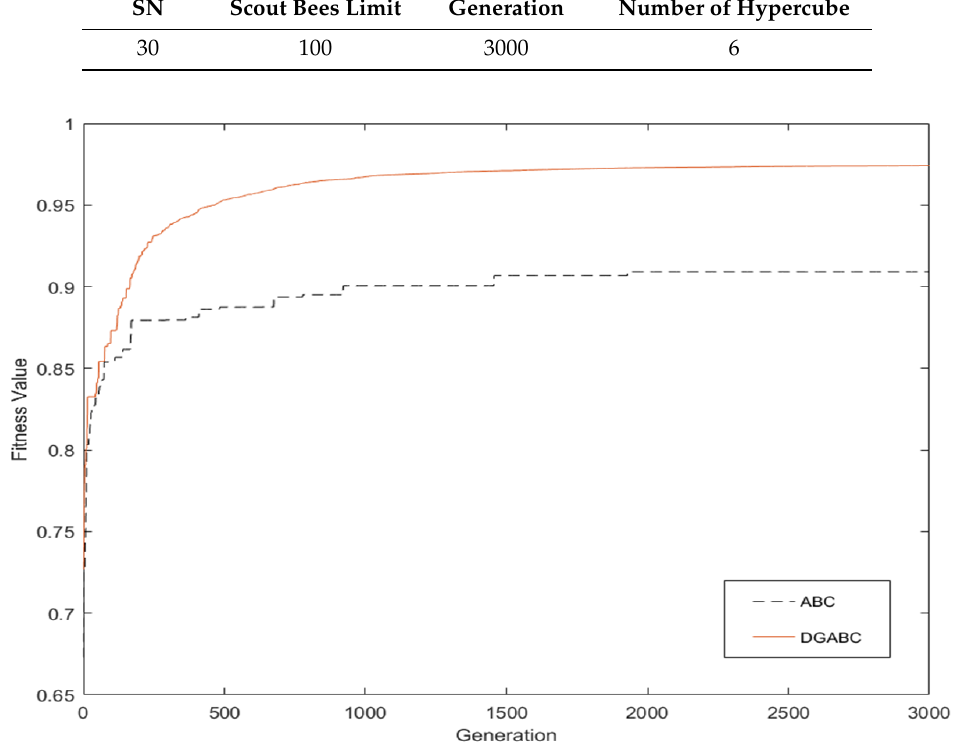
Figure 15. Learning curves of the conventional ABC and the proposed dynamic group artificial bee colony (DGABC).